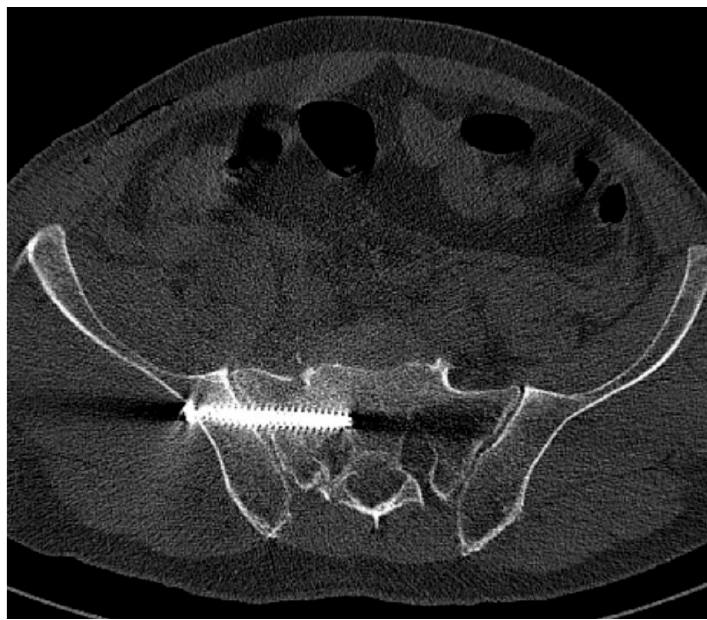
Figure 2. Screw touching the cortex (Smith type 1).